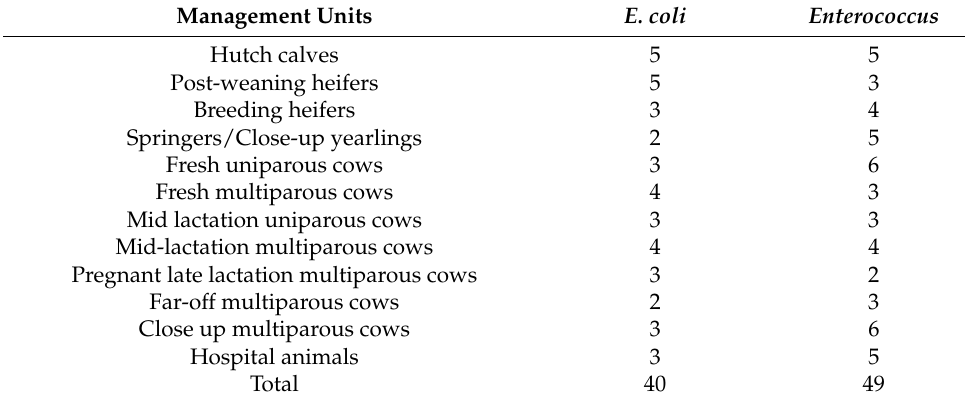
Table 3. Number of E. coli and Enterococcus isolates from twelve different production stages used in genotype characterization in this study. Management